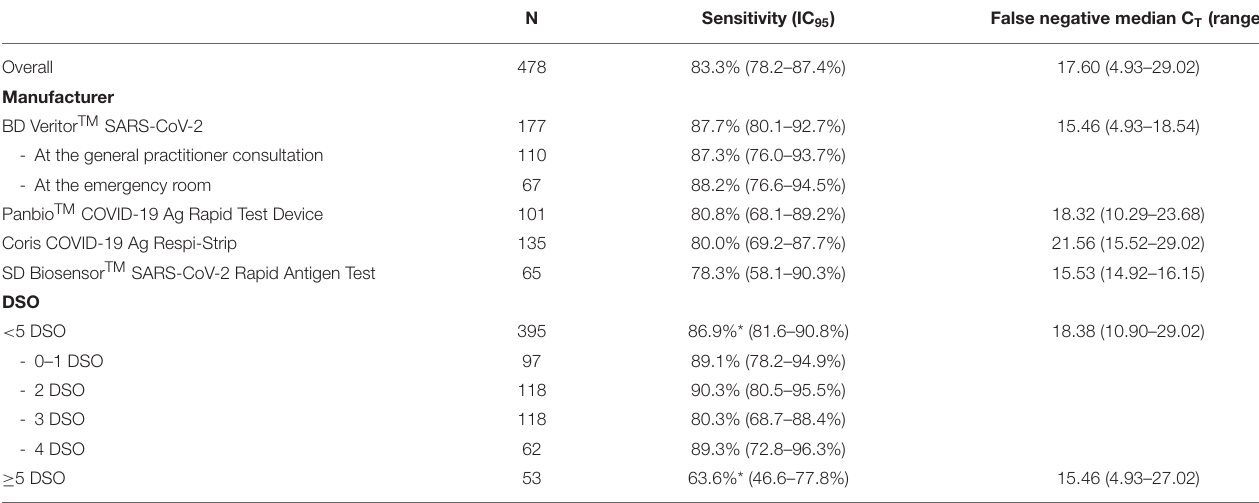
TABLE 2 | Compared analytical performances of four SARS-CoV-2 antigen rapid diagnostic tests used in a point-of-care setting at the emergency room of Saint-Pierre University Hospital (Brussels, Belgium) and at a general practitioner